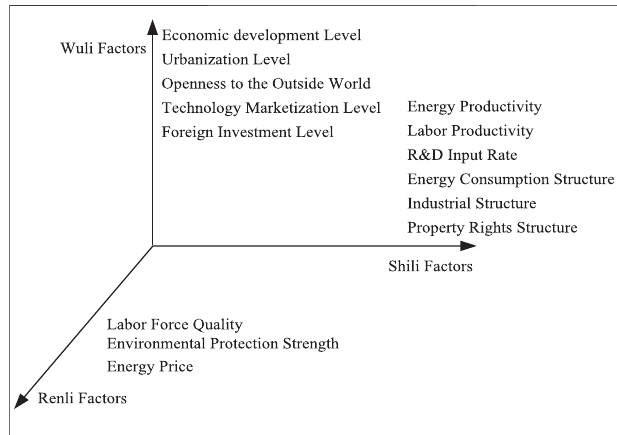
FIGURE 1 | 3D diagram of influencing factors of WSR